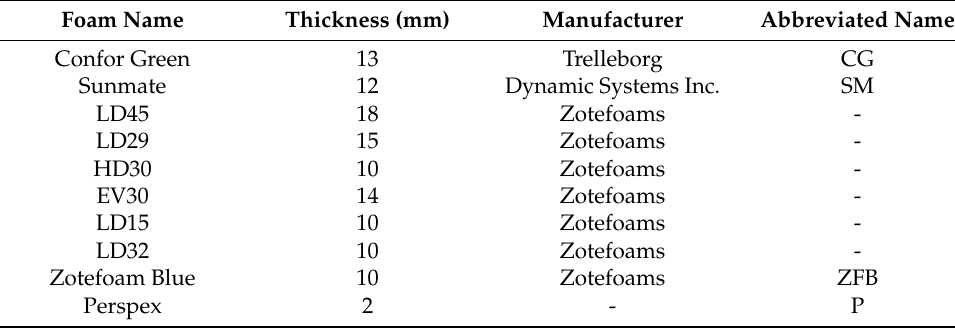
Table A1. Description of foams used for testing.